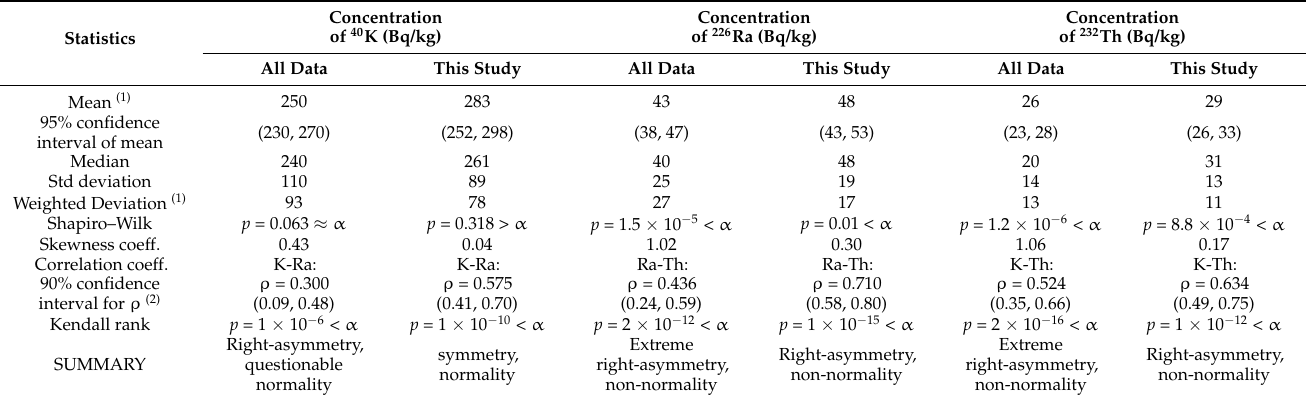
Figure 4. The violin-type plots of activity concentration of 40 K, 226 Ra and 232 Th. Data are grouped into “other studies” (left light-gray graphs) and “this study” (right dark-gray graphs). The violin-type plots are in fact a type of density plots and show how the measurements are distributed through the sample. Strong asymmetry is clearly visible in all plots for data from the other studies. Measurements performed by the authors reveal quite low asymmetry or even symmetry for 40 K concentration. Table 5. Descriptive statistics and results of statistical tests for all the gathered data, both experimental data from this study, and from other studies.